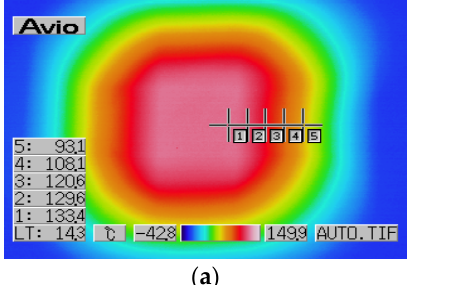
Figure 5. Heat distribution of the center point of 100 μ m thickness at 45 min: ( a ) Coating plane; ( b ) SUS304 plane.